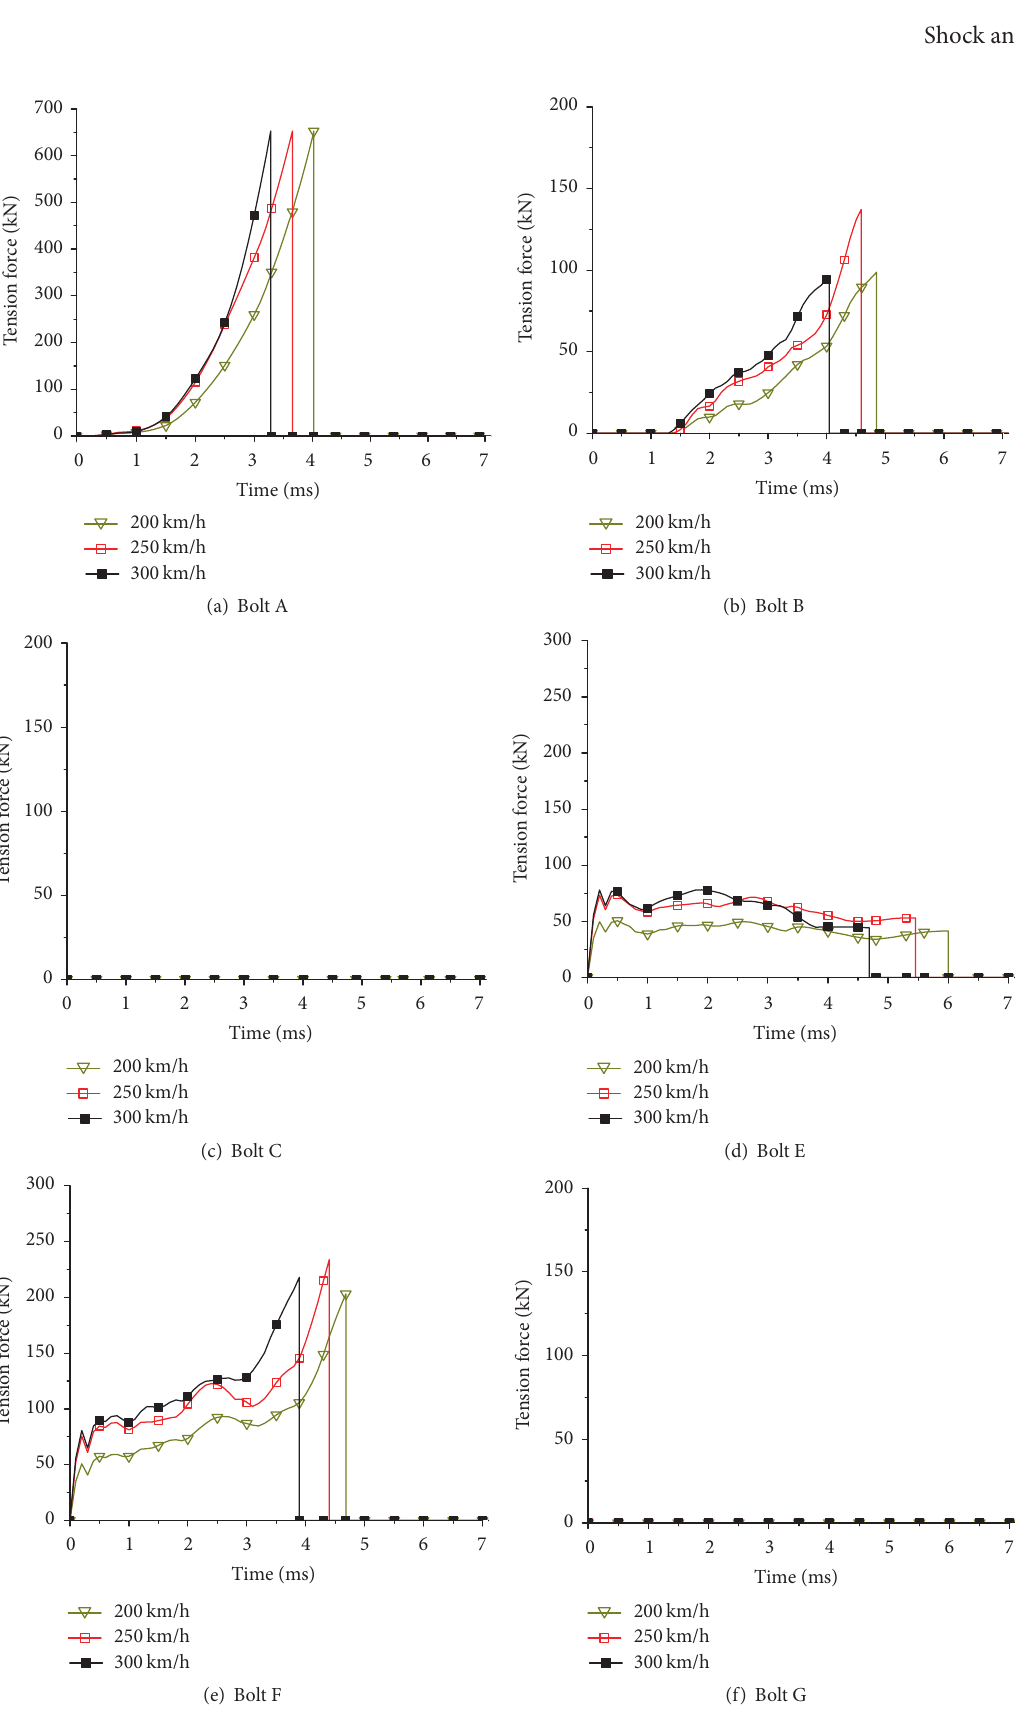
Figure 21: The tensile force time history curves for bolts A, B, C, E, F, and